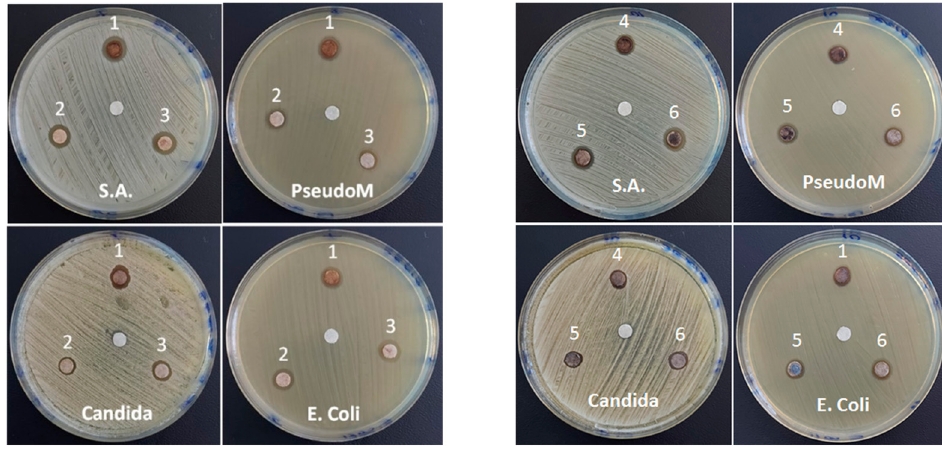
Figure 7. Disk diffusion assay for the investigated samples: AM1(1), AM1-S1(2), AM1-S2(3), AM2 (4), AM2-S1(5), and AM2-S2(6).